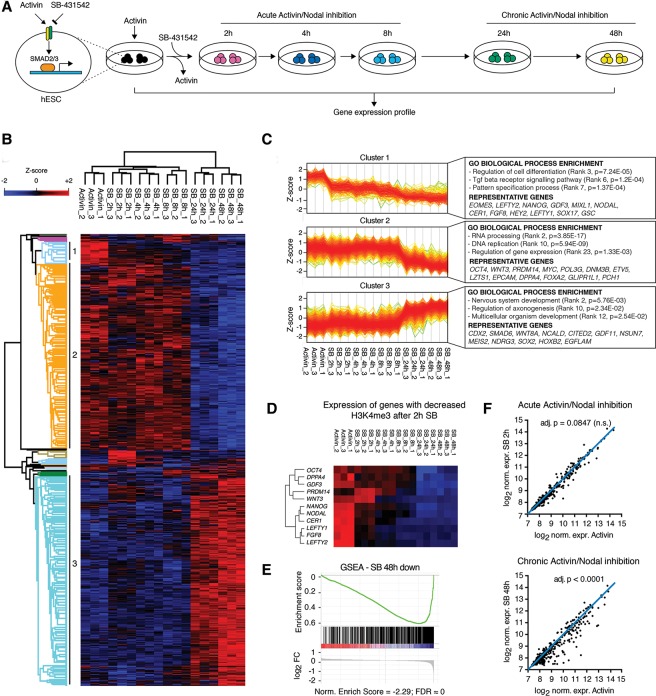
Dynamics of the transcriptional response to Activin/Nodal inhibition and their relationship with epigenetic changes. (A) Schematics of the experimental approach. (B) Euclidean hierarchical clustering of differentially expressed microarray probes across a time course of Activin/Nodal inhibition in hESCs (top 10% ranked by Hotelling T2 statistic). Z-scores indicate the differential expression measured in number of standard deviations from the average level across all the time points. The three major probe clusters are indicated. (C) Expression profiles of probes in the clusters indicated in B. Selected results of gene enrichment analysis and representative genes for each cluster are reported (Supplemental Table S2 contains the complete set of results). (D) As in B, but only selected representative genes that showed decreased H3K4me3 upon 2 h of inhibition of Activin/Nodal signaling are reported. (E) Gene set enrichment analysis (GSEA) for genes whose expression was decreased after 48 h of SB in the list of H3K4me3-associated genes ranked by the differential H3K4me3 enrichment before or after 2 h of SB. (F) Expression of the genes closest to the H3K4me3 peaks decreased after 2 h of SB. The blue lines indicate no expression change. The significance of expression differences after 2 h or 48 h of SB treatment versus Activin as calculated by Dunn's multiple comparisons tests is shown (see Supplemental Fig. S2B for results for other time points).